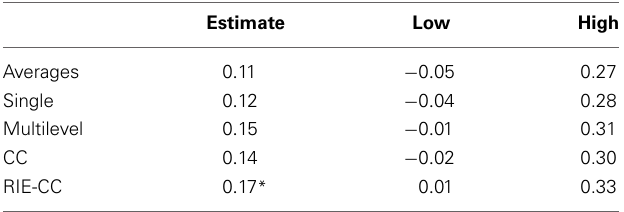
Table 6 | Correlation between observations scores and value-added